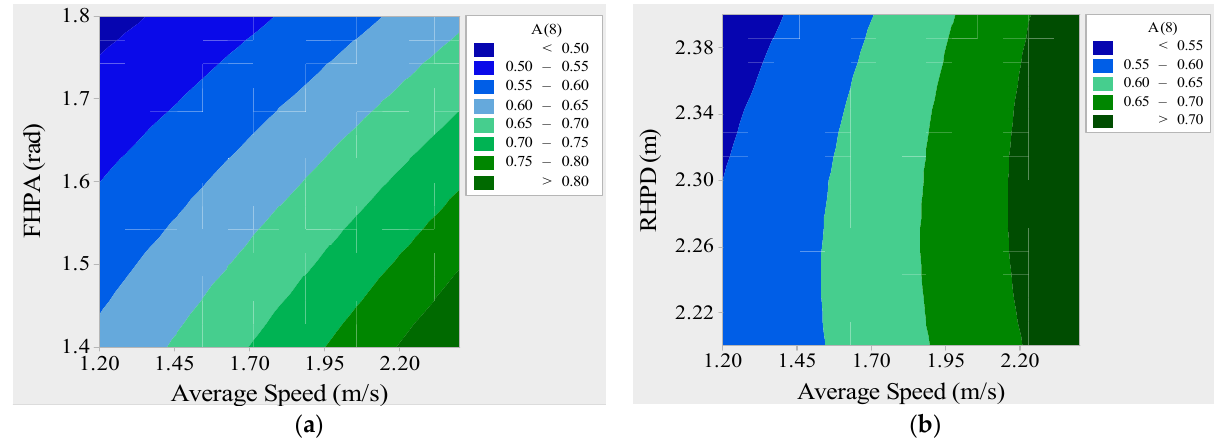
Figure 6. Effect on A(8) with respect to ( a ) FHPA and average speed; ( b ) RHPD and average speed.